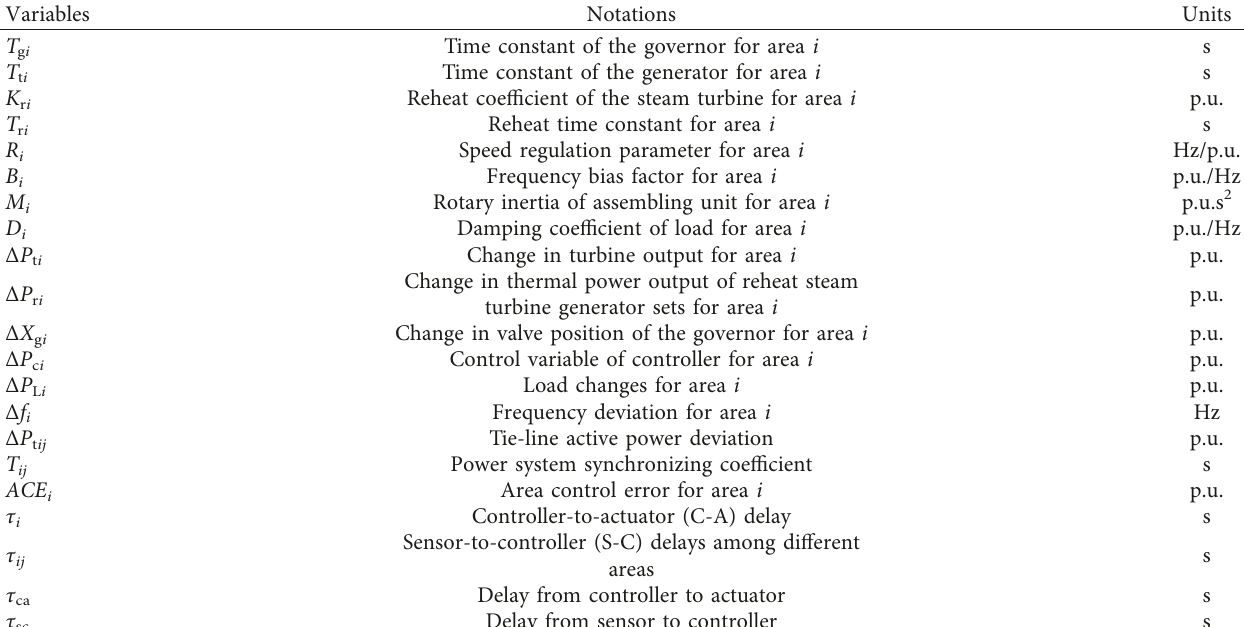
Figure 1: AGC dynamic model with two-channel delays. Table 1: Notations of